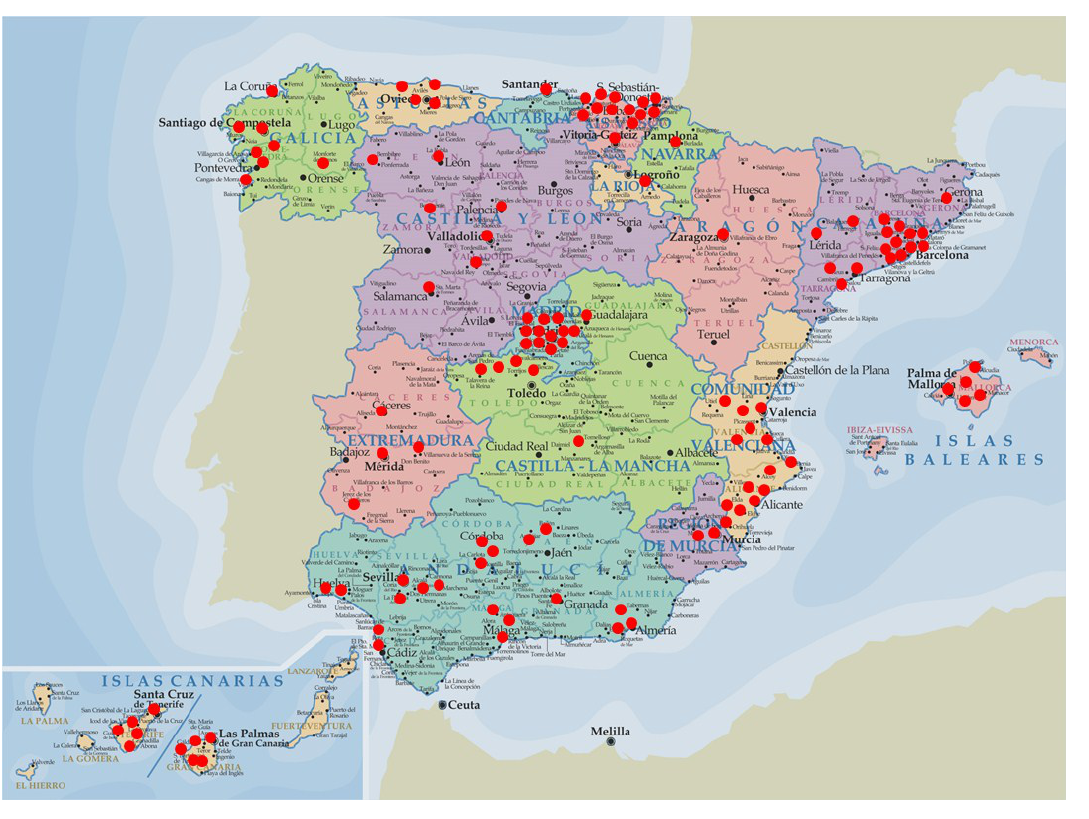
Figure 1. Geographical distribution of the sampling points for the ANIBES